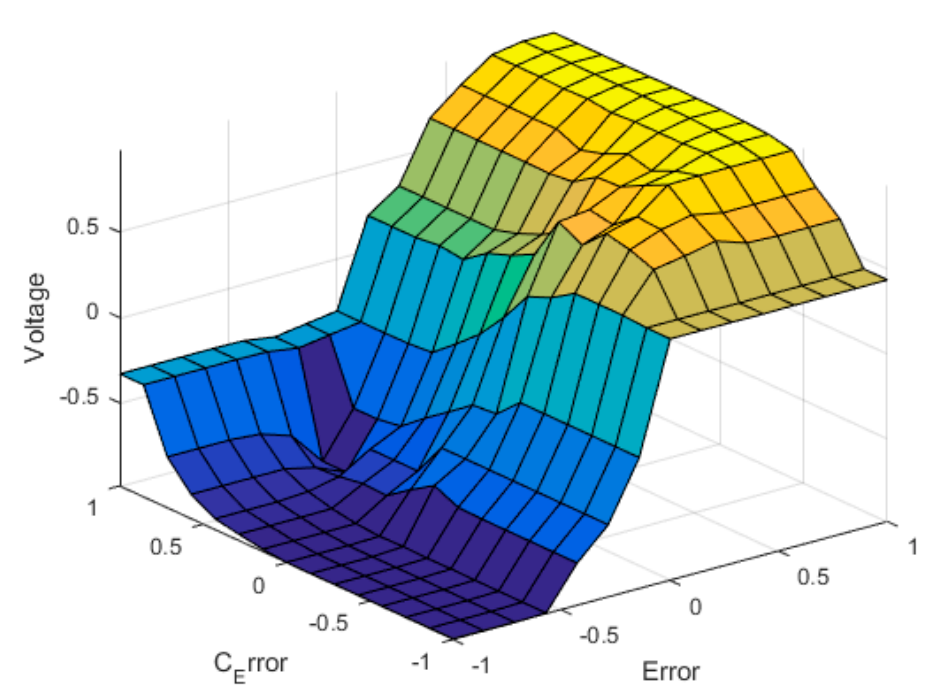
Figure 15. Surface of the best fuzzy system with noise.